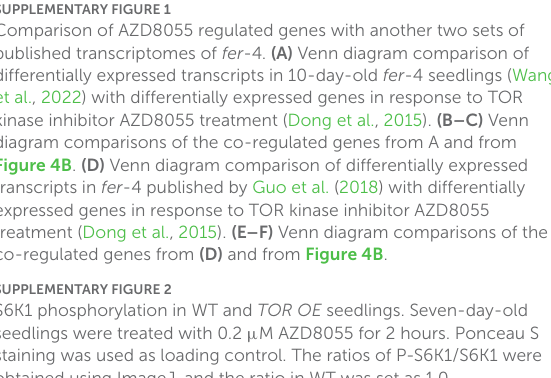
Figure 4B . (D) Venn diagram comparison of differentially expressed transcripts in fer -4 published by Guo et al. (2018) with differentially expressed genes in response to TOR kinase inhibitor AZD8055 treatment (Dong et al., 2015). (E–F) Venn diagram comparisons of the co-regulated genes from (D) and from Figure 4B